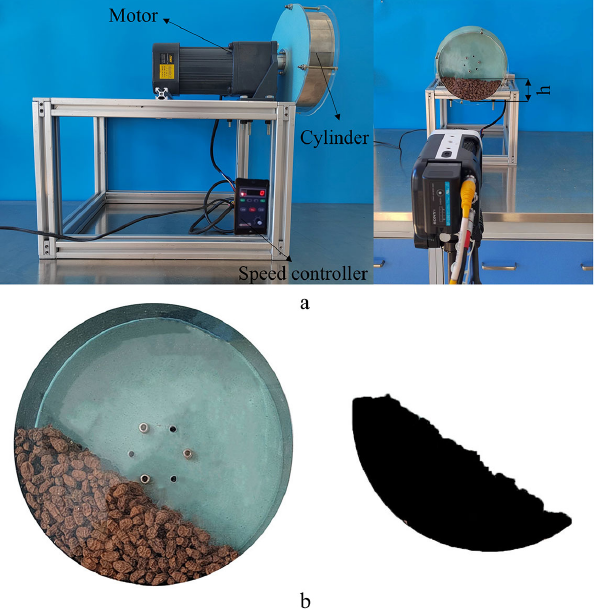
Figure 10. Rotating hub test: ( a ) photograph of the rotating hub test; ( b ) image binarization.